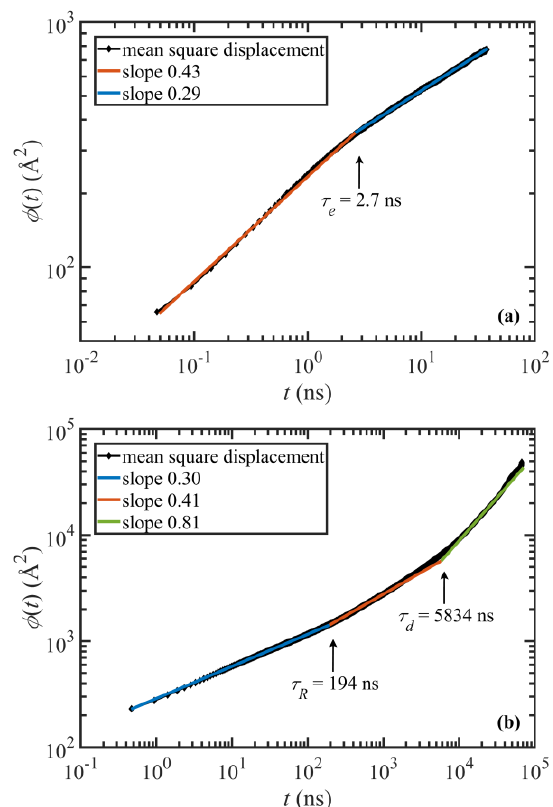
Figure 1. Short ( a ) and long ( b ) timescale segmental MSD versus time of the (500) centermost chain atomic units.